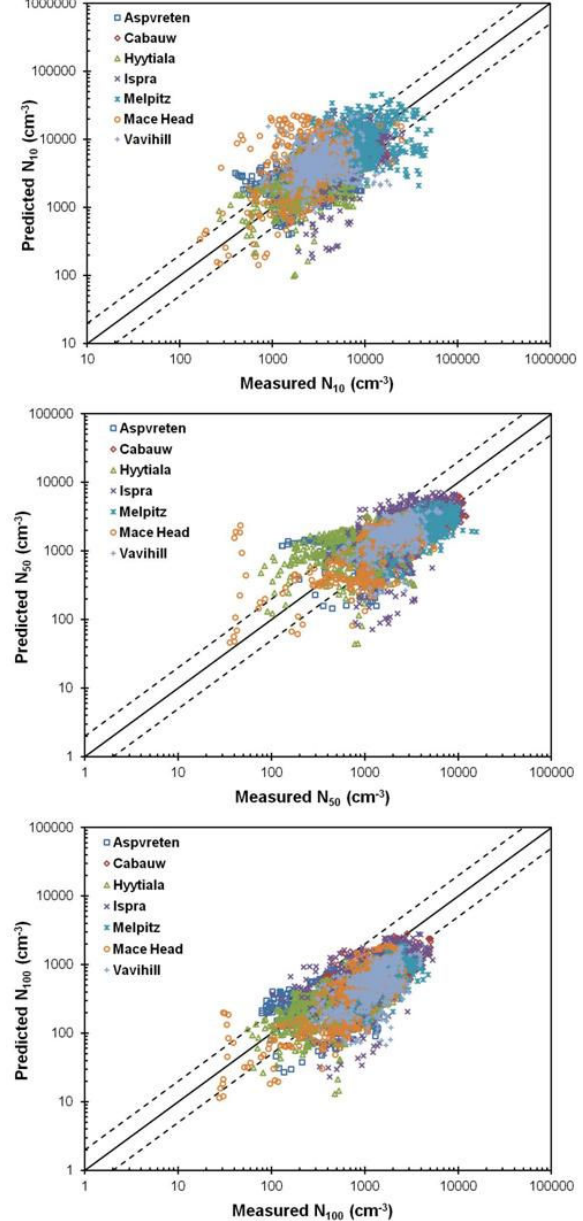
Figure 3. Comparison of predicted vs. observed particle number concentrations (cm -3 ) Fig. 3. Comparison of predicted vs. observed particle number con- centrations (cm − 3 ) above 10, 50 and 100nm from 7 measurement above 10, 50 and 100 nm from 7 measurement stations during May 2008. Each point stations during May 2008. Each point corresponds to a 1-h average corresponds to a 1-hour average value. Also shown the 1:1, 2:1 and 1:2 lines. value. Also shown the 1 : 1, 2 : 1 and 1 : 2